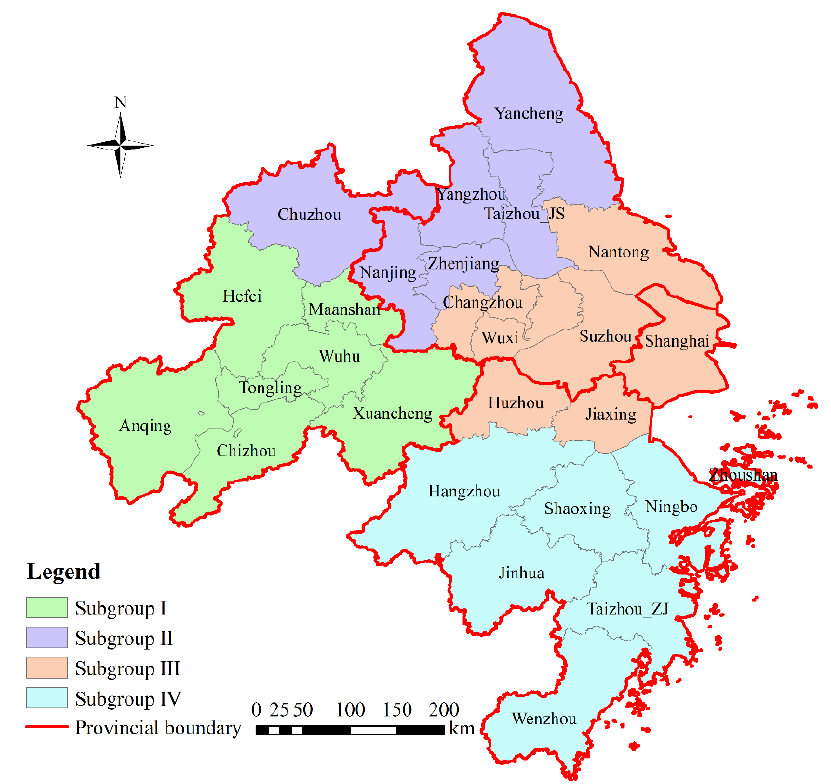
Figure 7. Composition and distribution of urban subgroups.